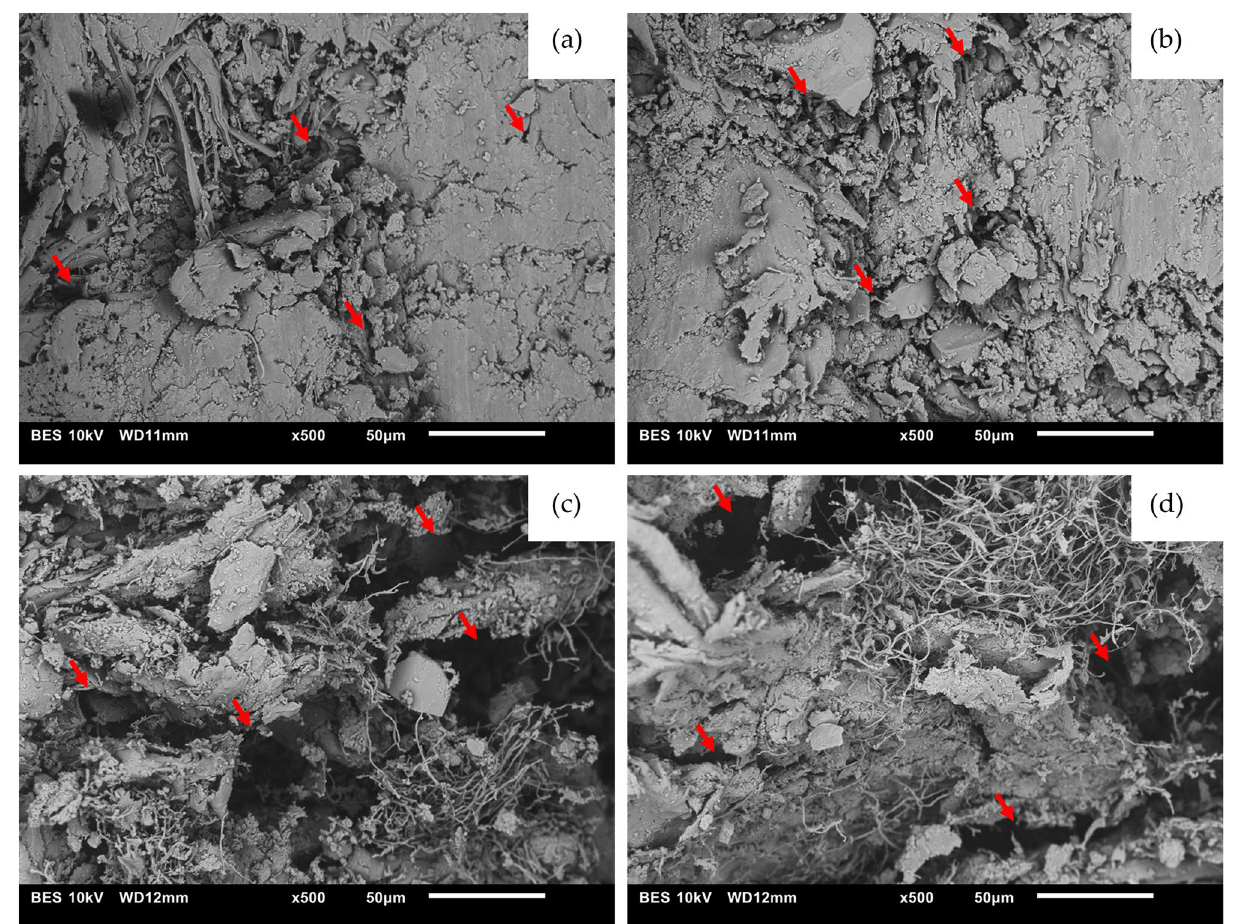
Figure 3. SEM images of different surfaces: ( a ) and ( b ) Surfaces with smoother textures and ( c ) and ( d ), Surfaces with more porous textures. Examples of pores are shown by arrows in the